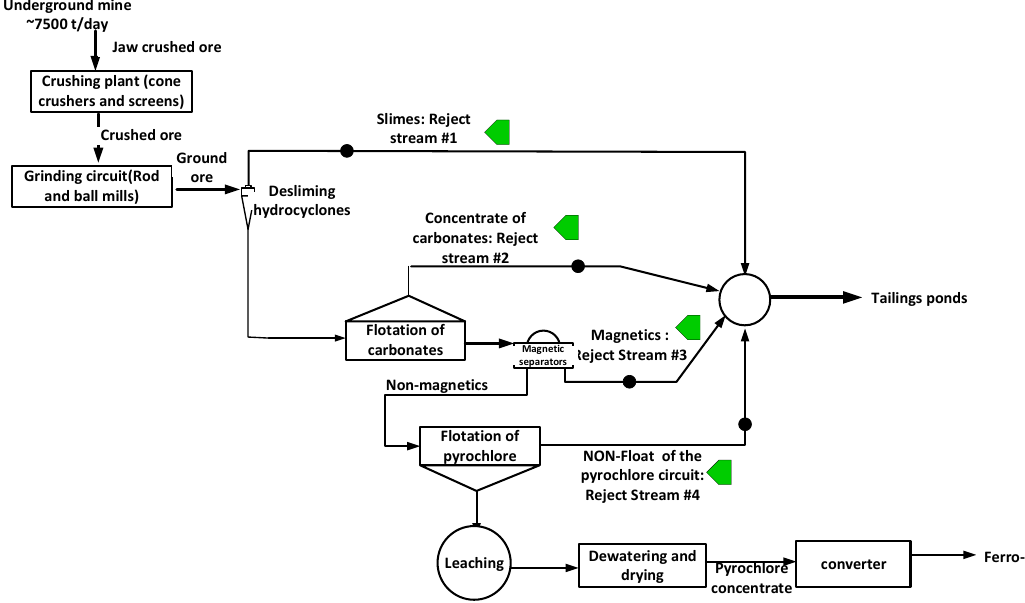
Figure 1. Simplified flowsheet of the Niobec concentrator showing the four reject streams.